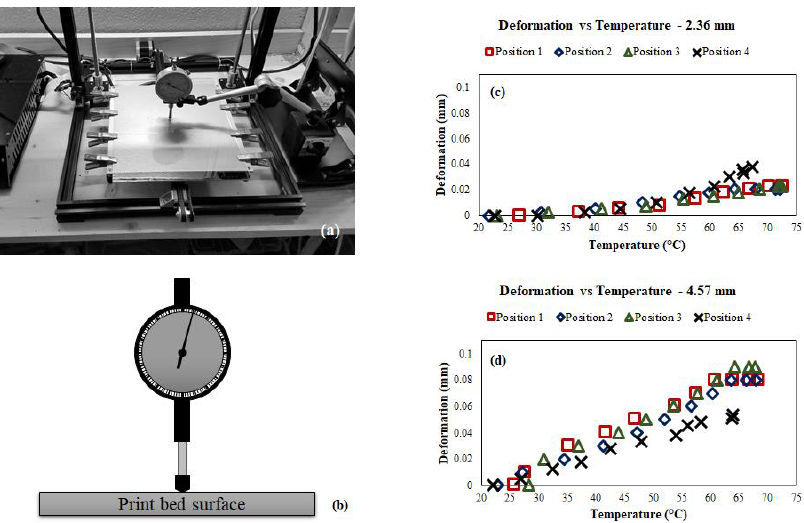
Figure 17. Heat deflection and warping study experimental setup where ( a ) shows the physical setup of the experiment, ( b ) shows the position of the gauge, and ( c – d ) show the results for the thin and thick PC plates, respectively.